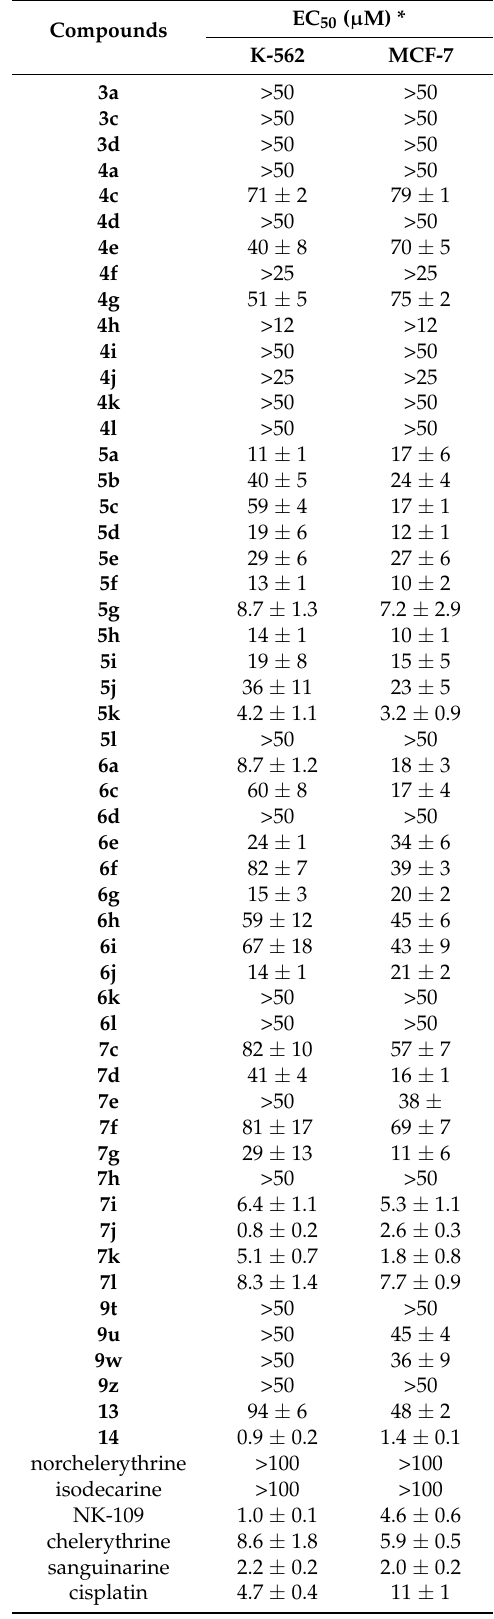
Table 3. Anticancer activity in